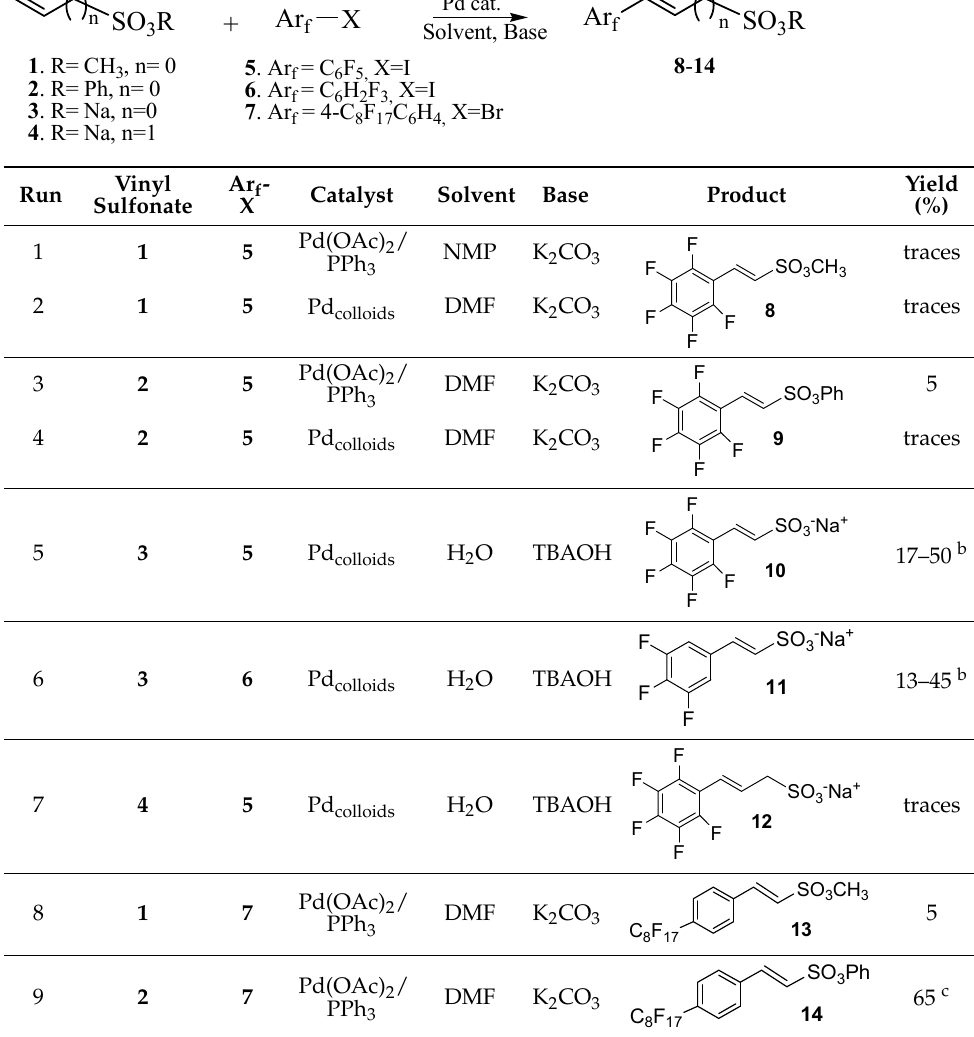
a Reaction conditions: sulfonate (0.5 mmol), perfluorohaloarene (0.5 mmol), K 2 CO 3 (or TBAOH, 1 mmol), Pd acetate (or Pdcolloids, 3 mol%), and PPh 3 (6 mol%) in 5 mL of DMF or water were heated at 120 ◦ C for 8 h (see Supporting Information). b Unreproducible reactions. Range of yields based on five attempts. Yields were evaluated by 1 H-NMR of the reaction mixture (see S.I.). c Isolated